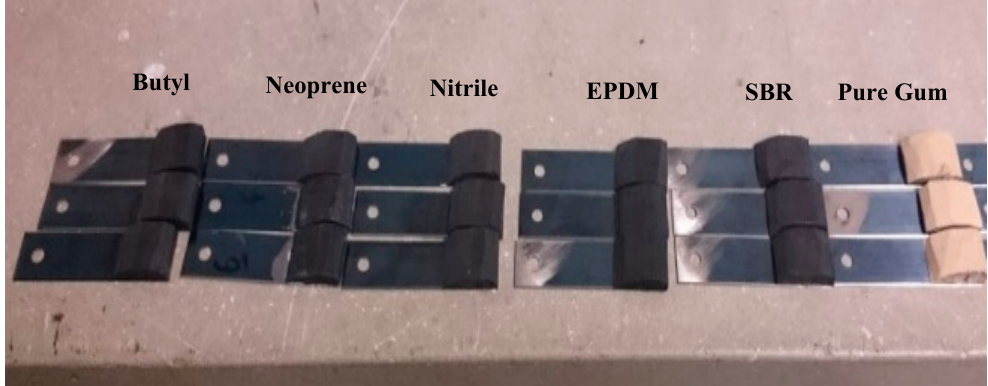
Figure 4. Prepared rubber sliders from test rubber materials.